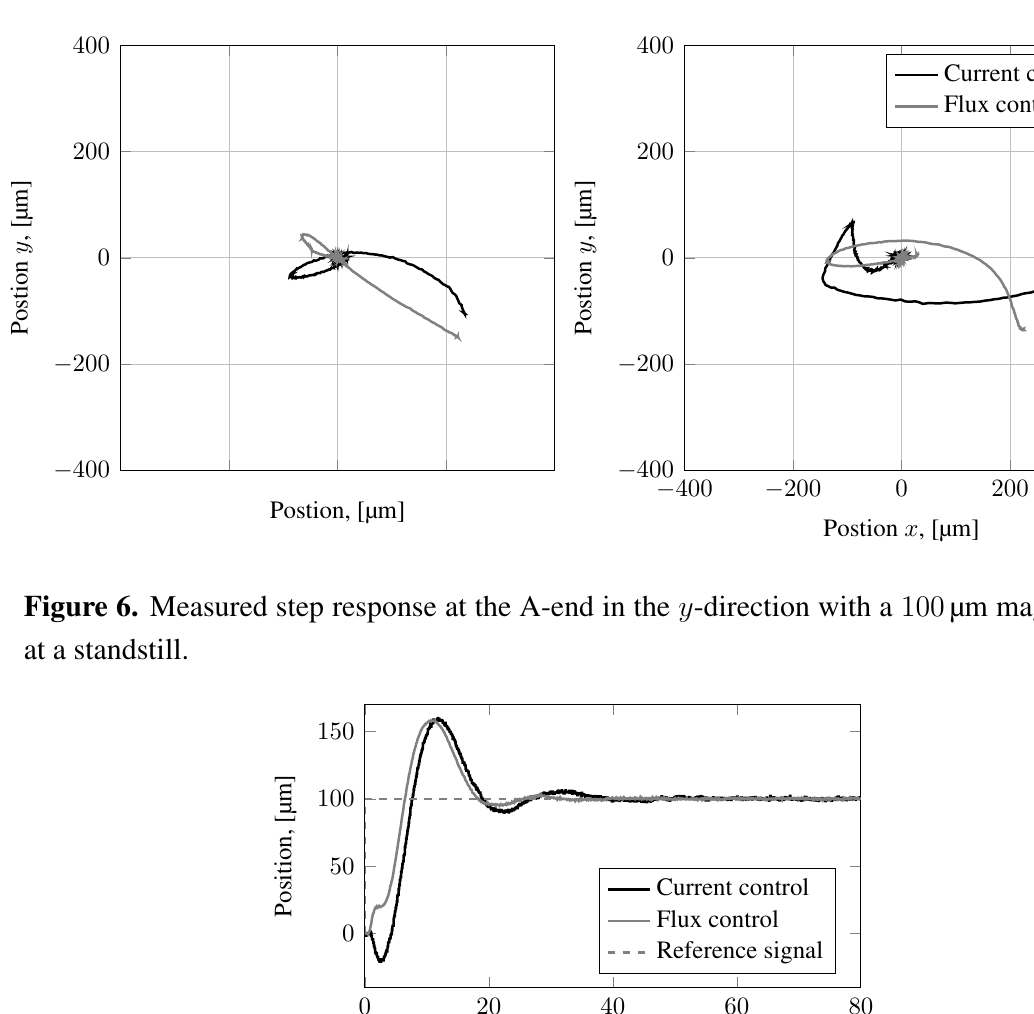
Figure 5. Measured initial levitation of the rotor from the safety bearings at both rotor ends. ( Left ) The B-end; ( Right ) the A-end.